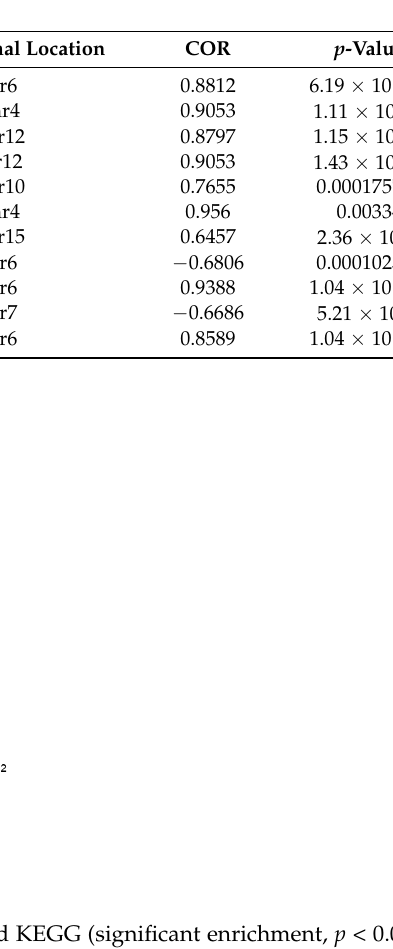
Table 2. The list of top 10 regulatory genes and their co-expressed lncRNA. The correlation (COR) represented Pearson-correlation.